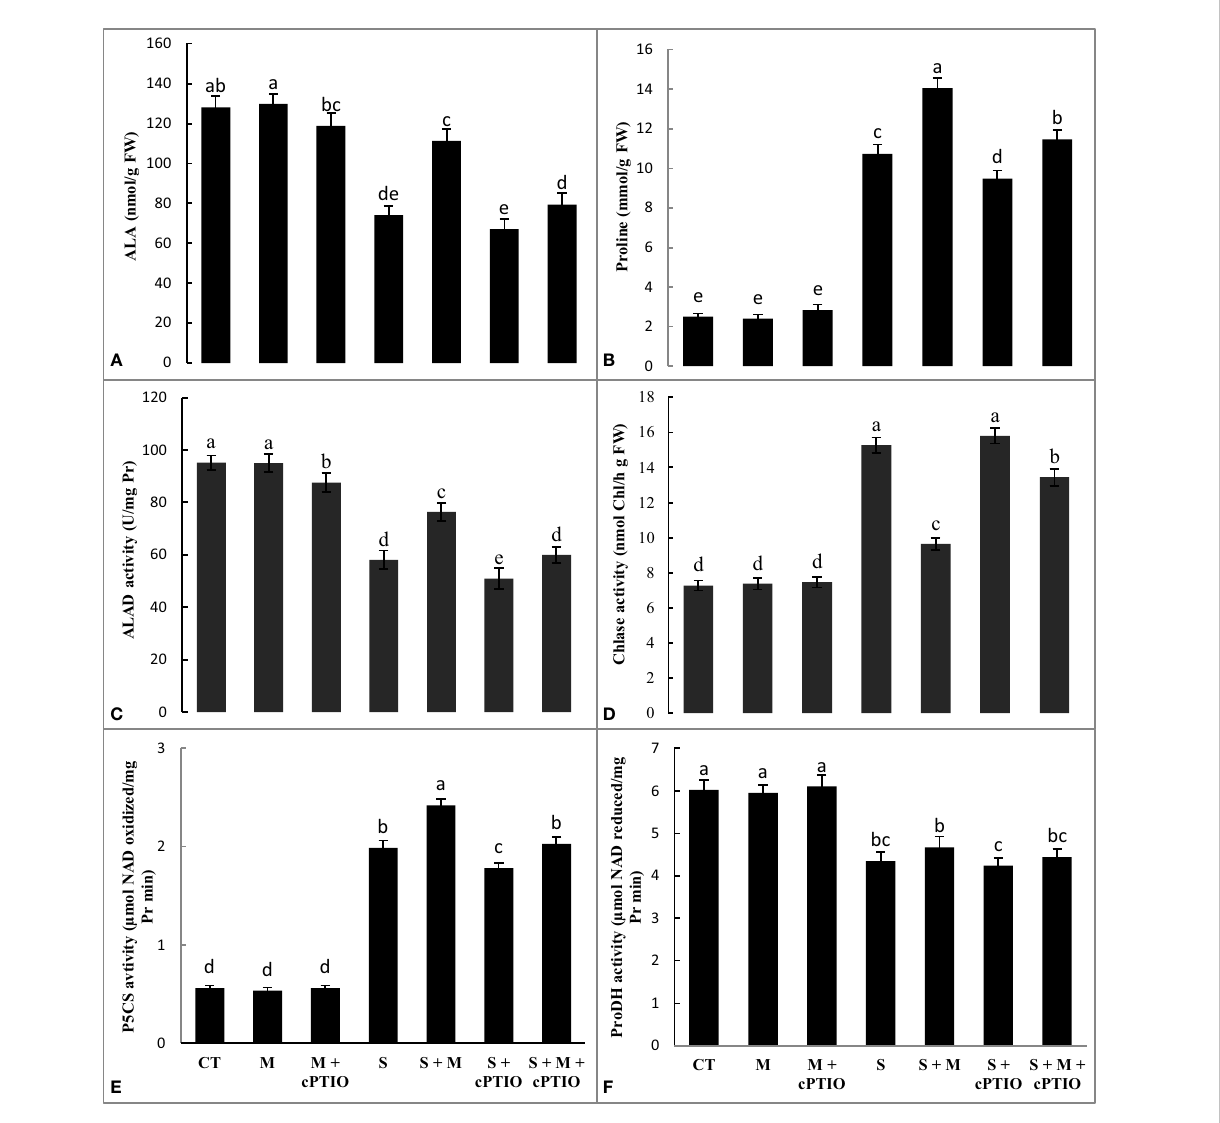
FIGURE 1 The leaf contents of minolevulinic acid (ALA, A ) and proline (B) , and the leaf activities of aminolevulinic acid dehydratase (ALAD, C ), chlorophyllase (Chlase, D ), pyrroline-5-carboxylate synthetase (P5CS, E ), and proline dehydrogenase (ProDH, (F) enzymes in tomato seedlings treated with melatonin (150 m M) and cPTIO (100 m M) under NaCl (150 mM) treatment. Different letters in each column show signi fi cant differences at the p < 0.05 based on the LSD test (means ± SD, n = 5), CT, control treatment; M, melatonin; S,